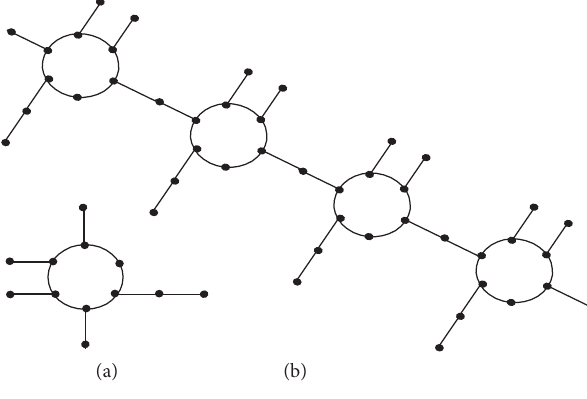
Figure 2: (a) Graph of amylose for n � 1 and (b) graph of amylose for n � 4. Table 1: Edge partition of edges based on the degree of vertices. Types of